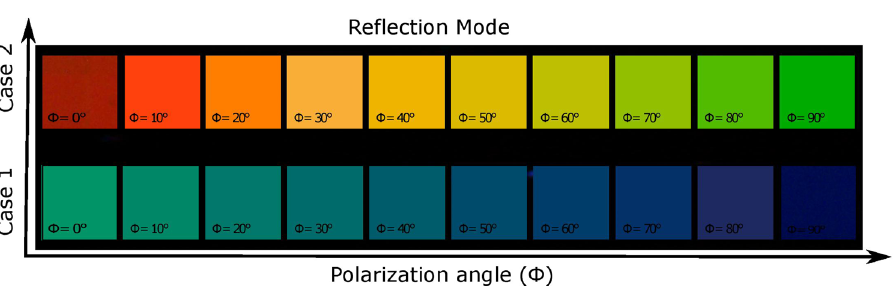
Figure 6. Colors visible under optical microscope in reflection mode when Φ is gradually varied from 0° to 90°. Dimensions of nanoantennas are given in Table